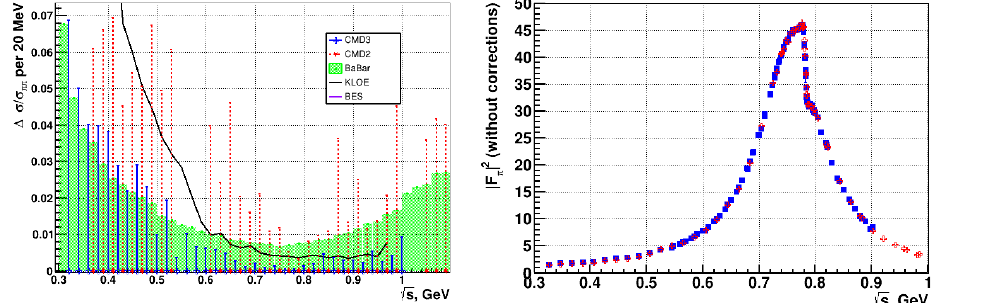
Figure 3. Statistical precision of | F π | 2 from the CMD-3 data collected during the 2013 and 2018 seasons in comparison with the results from CMD-2, BaBar, KLOE and BESIII